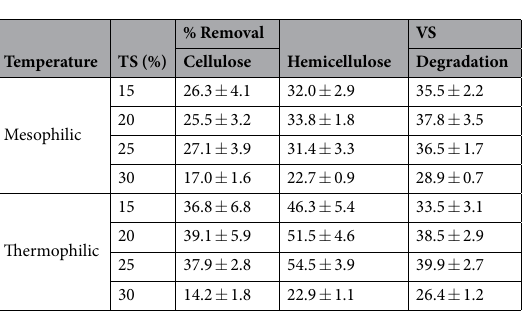
Table 4. Cellulose, hemicellulose and VS removal (p < 0.05) after 60 days of